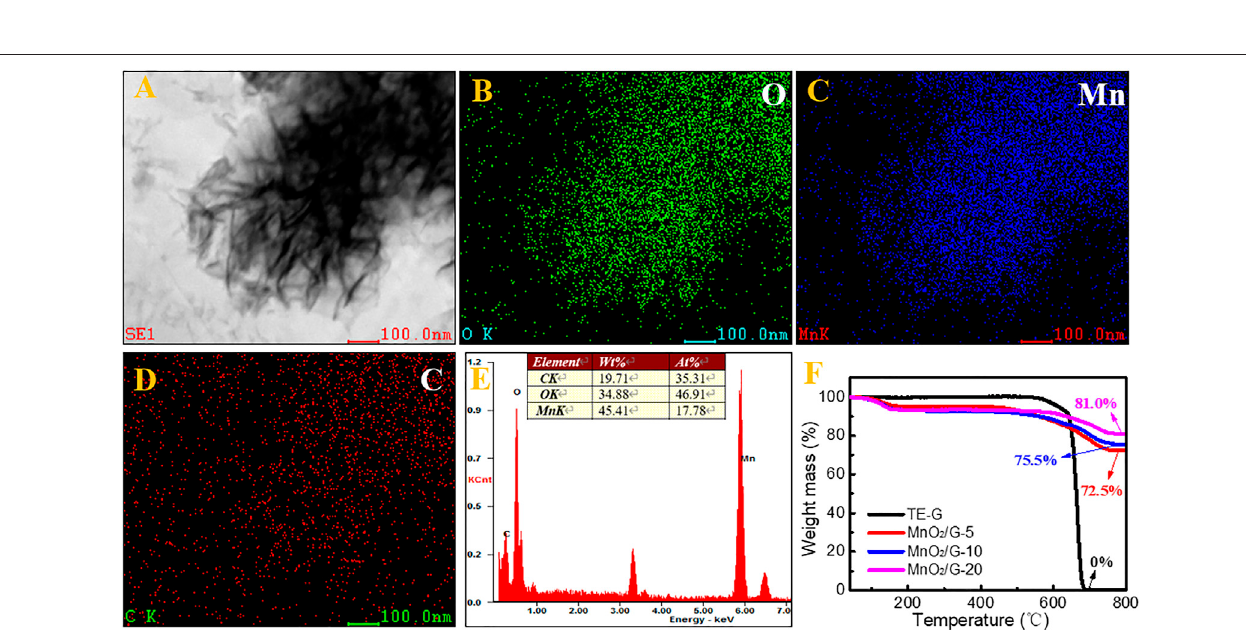
FIGURE4| ThemicrostructureoftheMnO 2 /G-10compositeobservedbySTEM (A) ,theelementalmappingofO (B) ,Mn (C) ,andC (D) ,correspondingelemental fraction (E) , and thermogravimetric curves of TE-G and MnO 2 /G composites (F) .